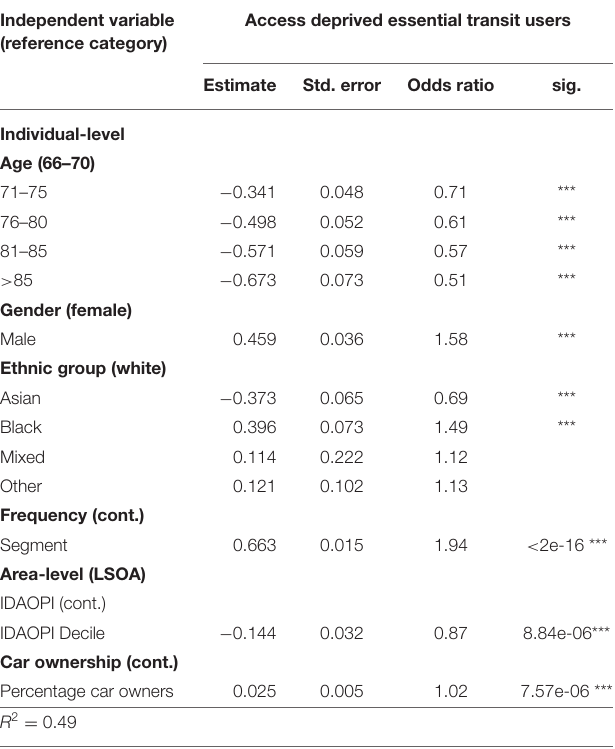
TABLE 2 | Multilevel logistic regression with “access deprived” (“yes” and “no”) as the dependent variable. Independent variable (reference